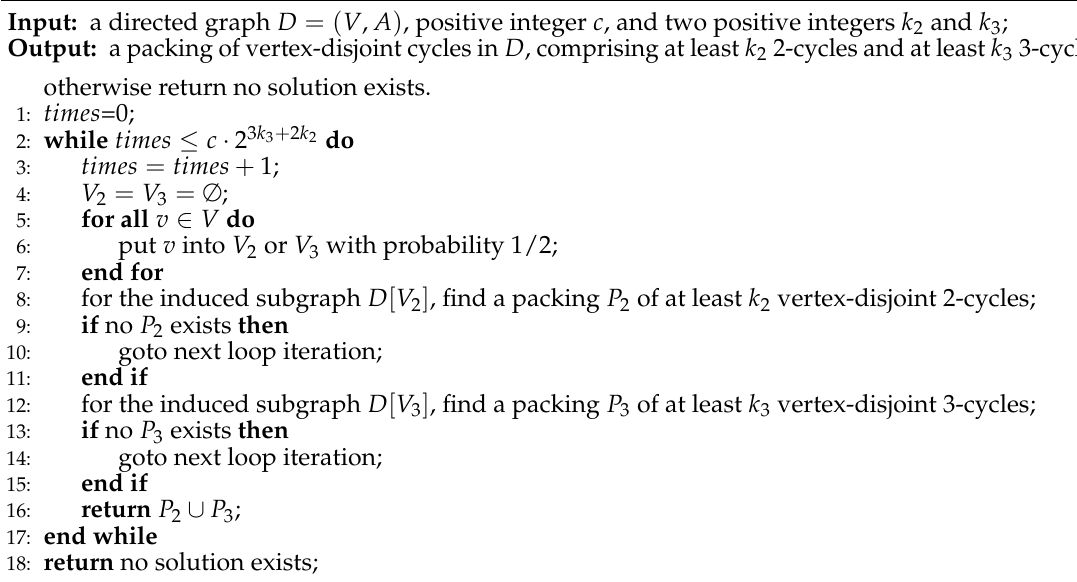
Algorithm 1 RKEP ( D , k 2 , k 3